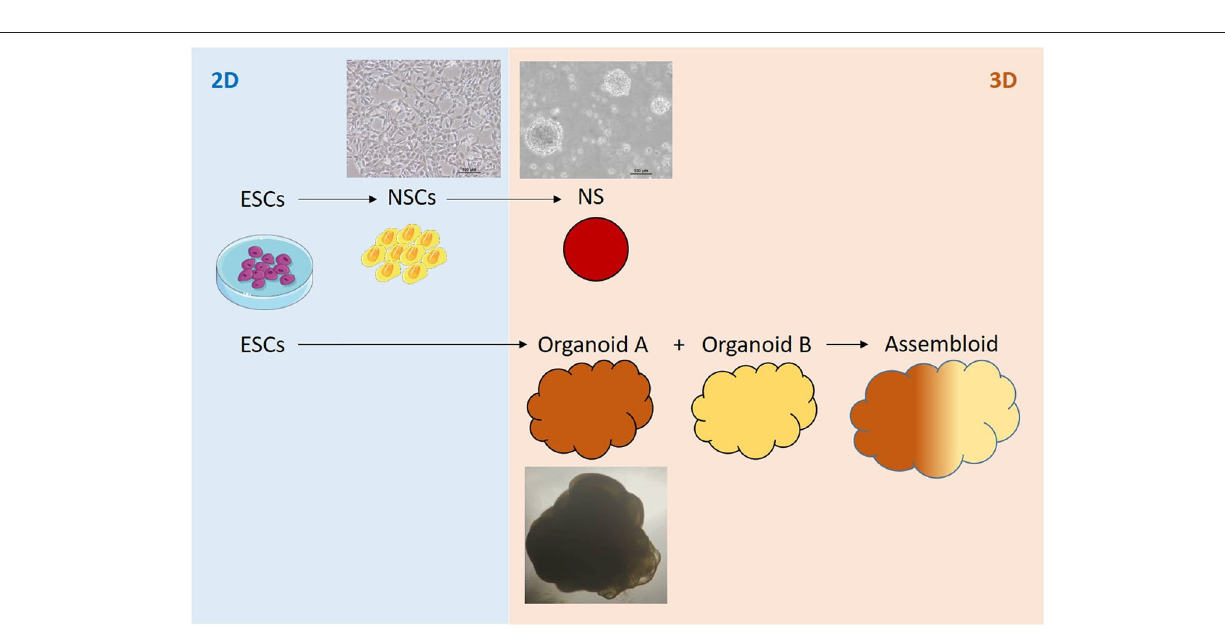
FIGURE 3 | Pluripotent, embryonic stem cell (ESCs) -based 2D-, 3D cell- and organoid systems as in vitro tools for studying the effects of ionizing radiation on the human